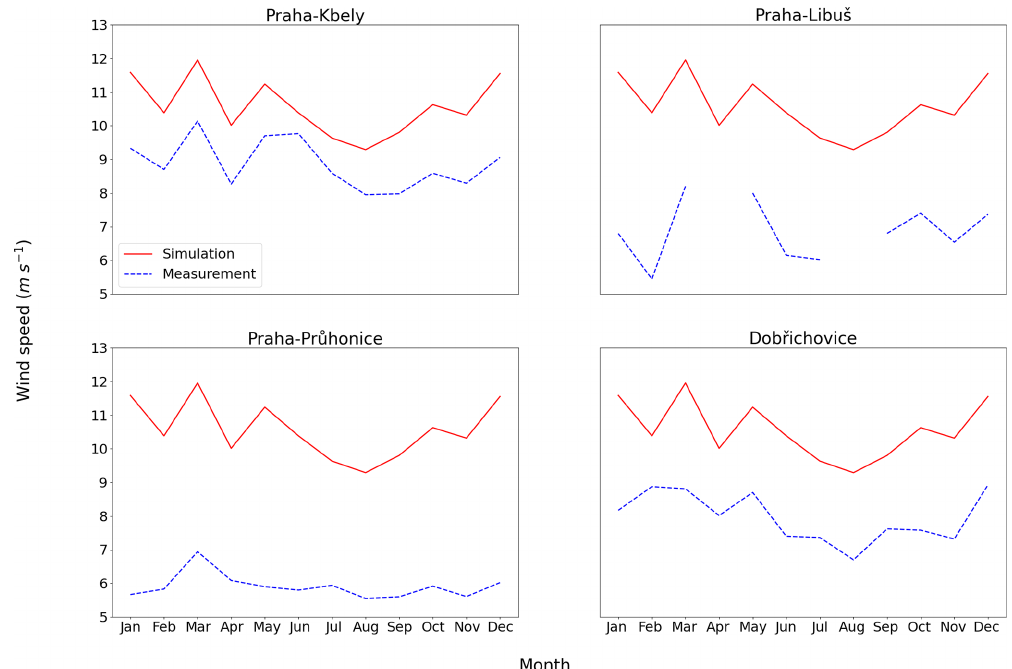
Figure 16. Annual cycle of monthly averaged maximum daily wind speeds from model simulations (red) and observations from four station in or around Prague (blue); averaging is done for days when the daily PM 10 model bias is larger than 50µgm − 3